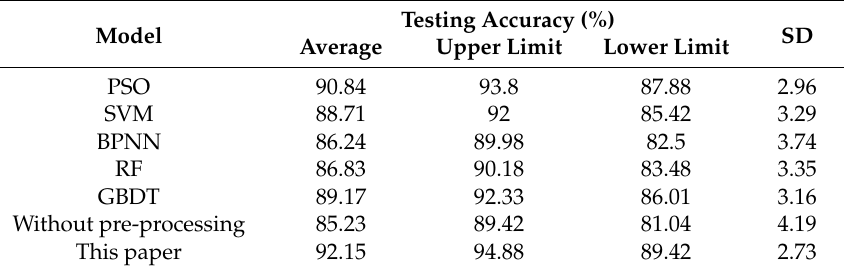
Table 6. Comparison of 10 random